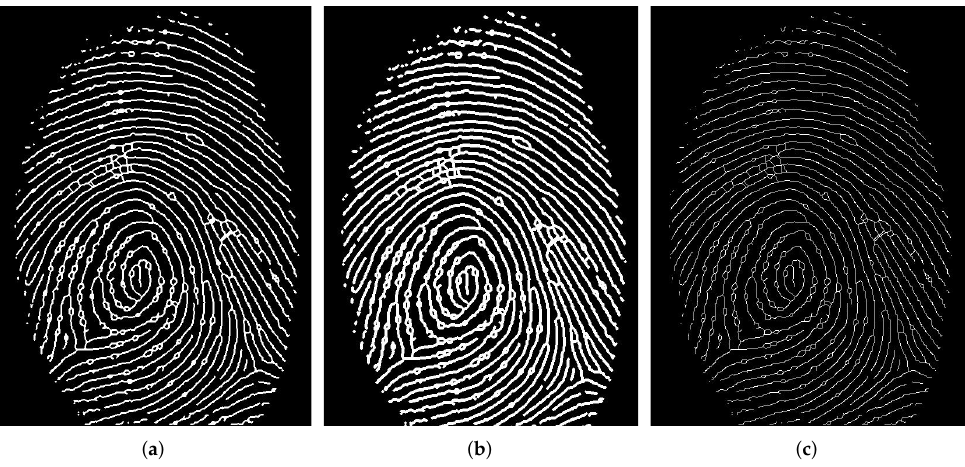
Figure 5. Main steps of fingerprint preprocessing: ( a ) thinning, ( b ) dilation and ( c ) unwanted pattern